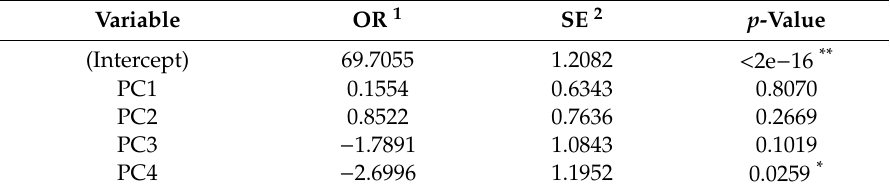
Table 2. Multiple linear regression with selected components from PCA in relation with food preference of kennel dogs.